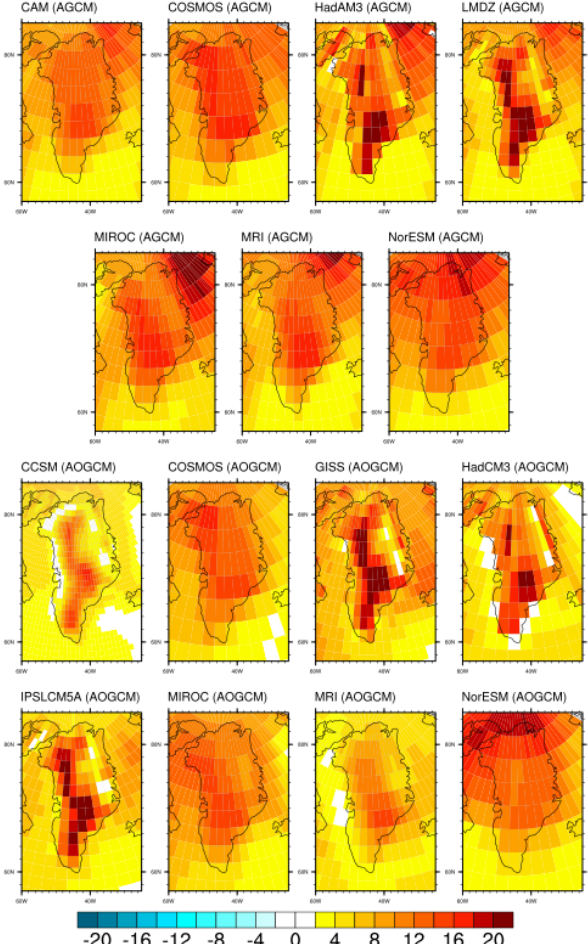
Figure 2. mPWP minus pre-industrial mean annual surface air temperature ( ◦ C) over Greenland for the PlioMIP ensemble using atmosphere-only (AGCMs) and coupled atmosphere–ocean climate models (AOGCMs). Temperature plotted on the original climate model